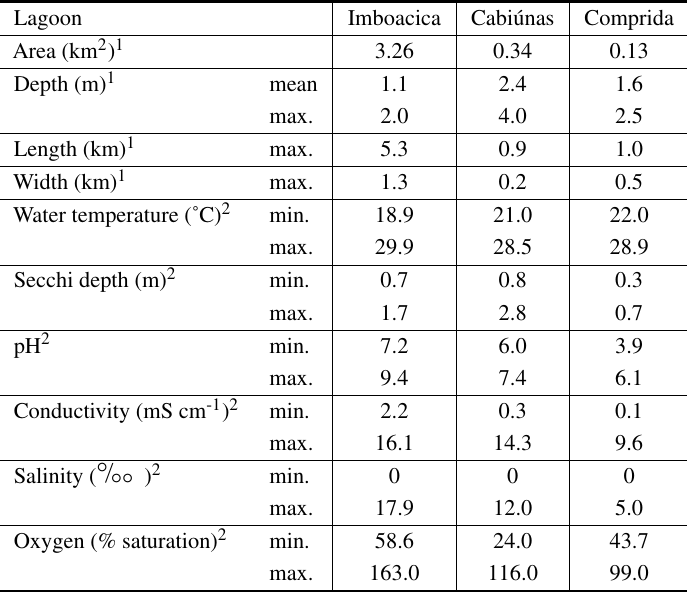
Selected morphological and limnological parameters of Imboacica, Cabiúnas and Comprida